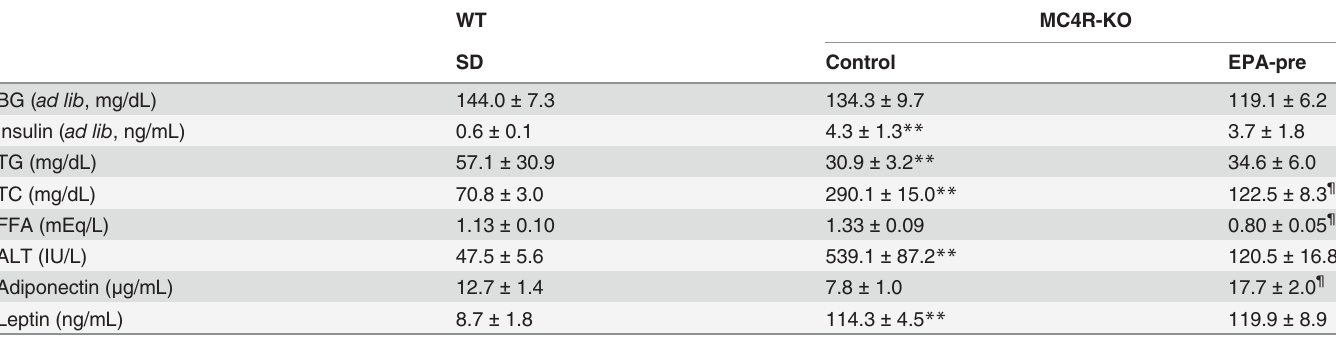
Table 1. Serological parameters of MC4R-KO and WT mice treated with EPA for 24